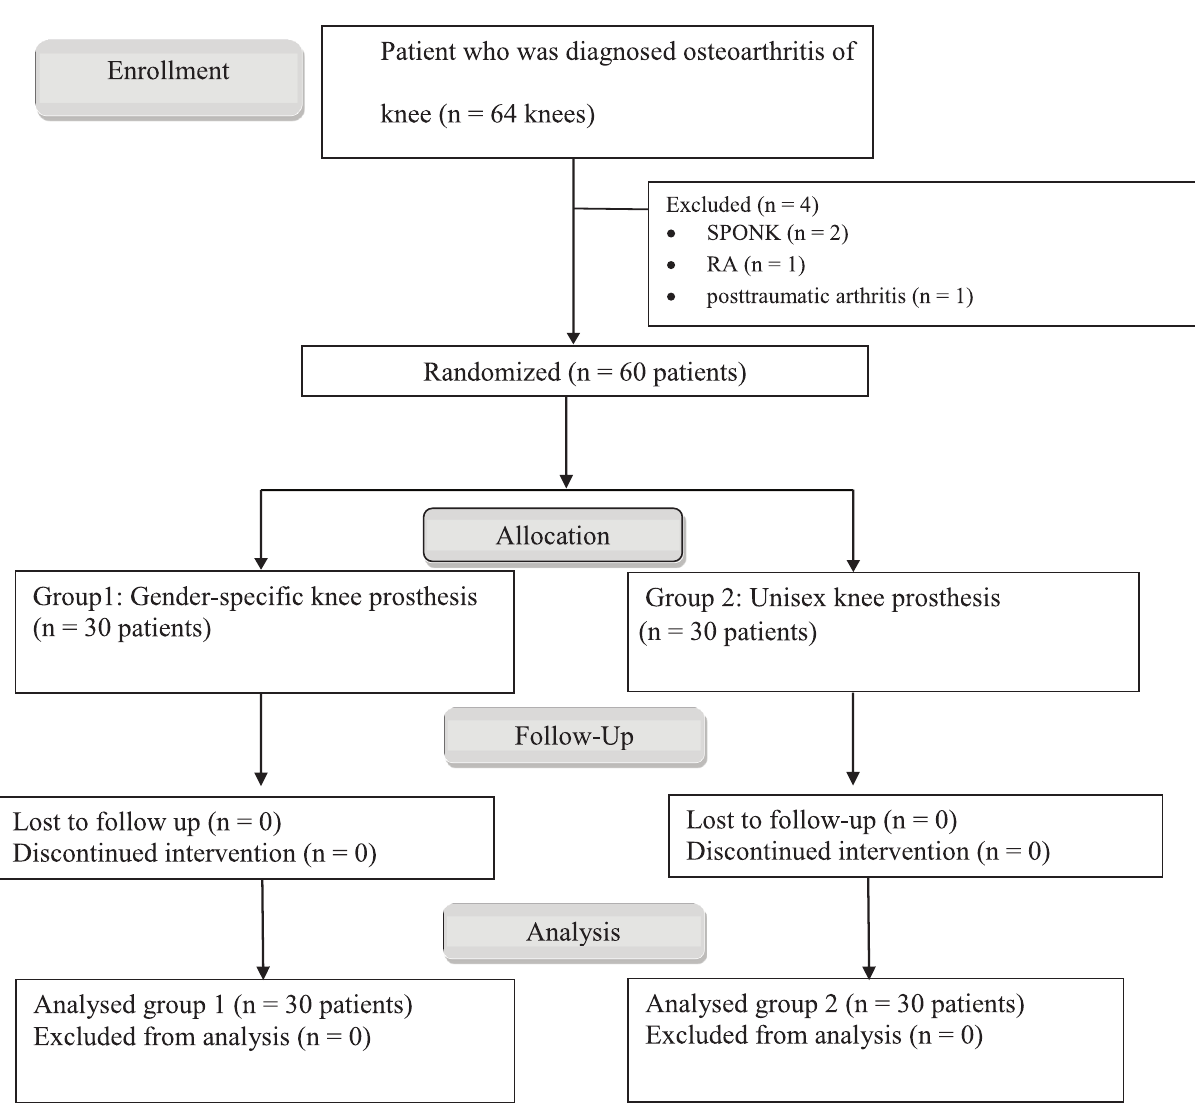
Figure 3. Flow chart protocol of this study (RA: rheumatoid arthritis, SPONK: spontaneous osteonecrosis of